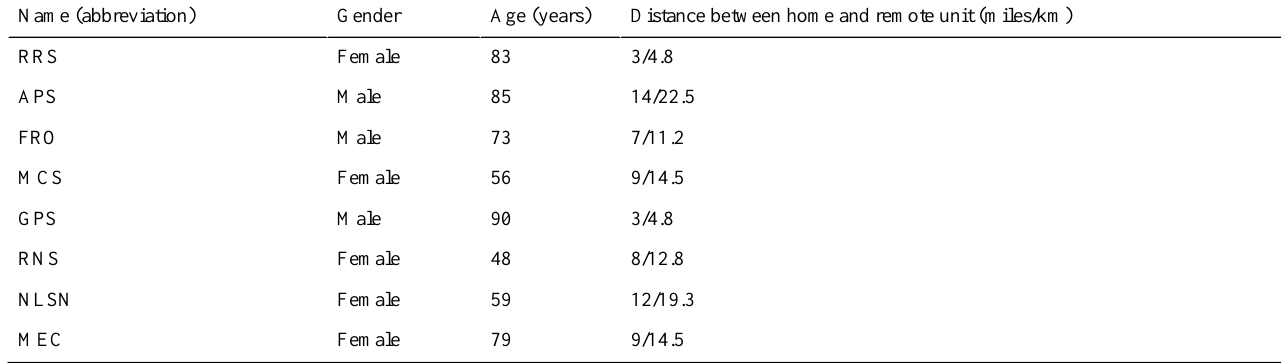
Table 6. Summary of participant